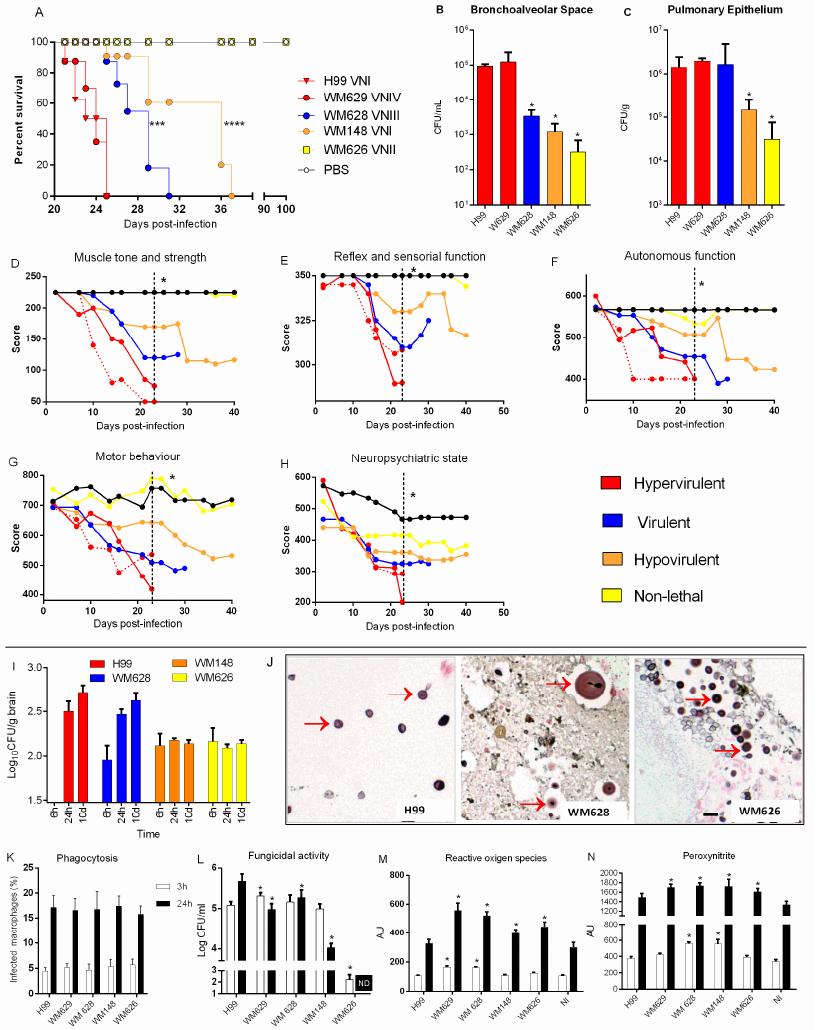
Figure 2. Virulence analysis of C. neoformans strains in vivo and ex vivo. ( A ) Mortality curve of mice after intratracheal infection with 1 × 10 5 cells (*** p < 0.001 and **** p < 0.001). ( B , C ) Fungal burden determination from the bronchoalveolar space (BS) and pulmonary epithelium (PE) 10 days post infection. ( D – H ) Behavior analysis after infection with C. neoformans strains. Dashed lines indicate the statistical difference in virulent, hypovirulent, and non-lethal strains compared with H99 (* p < 0.05). Virulence was classified according to the mean lethality time (MLt), with hypervirulent (red) range of MLt = 21–25 days, virulent (blue) range of MLt = 26–31 days, hypovirulent (orange) range of MLt = 32–40 days, and non-lethal (yellow) range of MLt => 100 days. ( I ) Fungal burden in the brain after 6 h, 24 h, and 10 days of intratracheal infection. ( J ) Brain stained with Fontana–Masson after 10 days of intracranial infection. Red arrow indicates the stained fungus due to the presence of melanin in the cell wall. Scale bar: 10 µm. ( K ) Phagocytic index after 3 h and 24 h infection. ( L ) Colony forming unit (CFU) determination represents viable yeast cells internalized by macrophages in each time point. ( M ) ROS and ( N ) PRN production after 3 and 24 h of infection by C. neoformans . Mean values were compared with H99 (* p < 0.05). AU: arbitrary units of fluorescence. NI: non-infected macrophages.